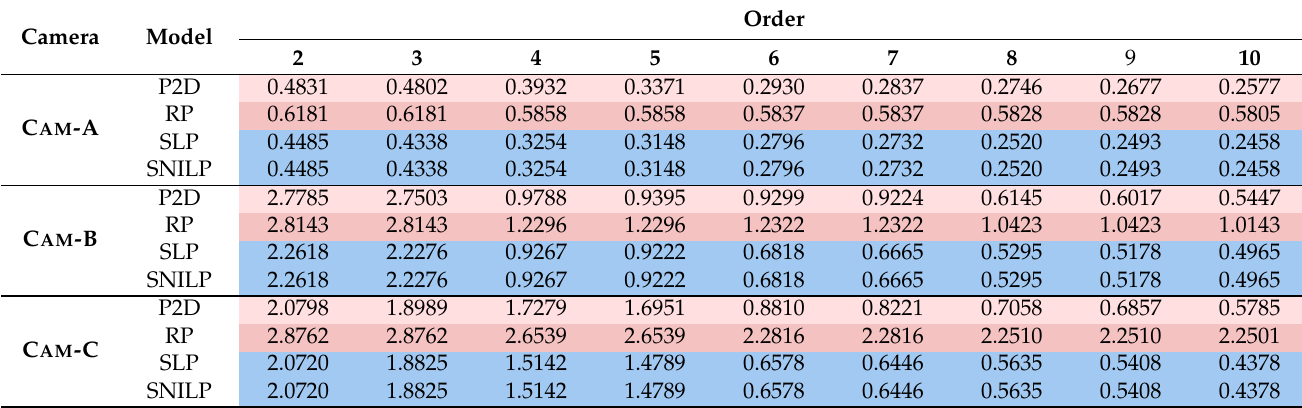
(cid:0) (cid:1) values. (cid:101) I flat